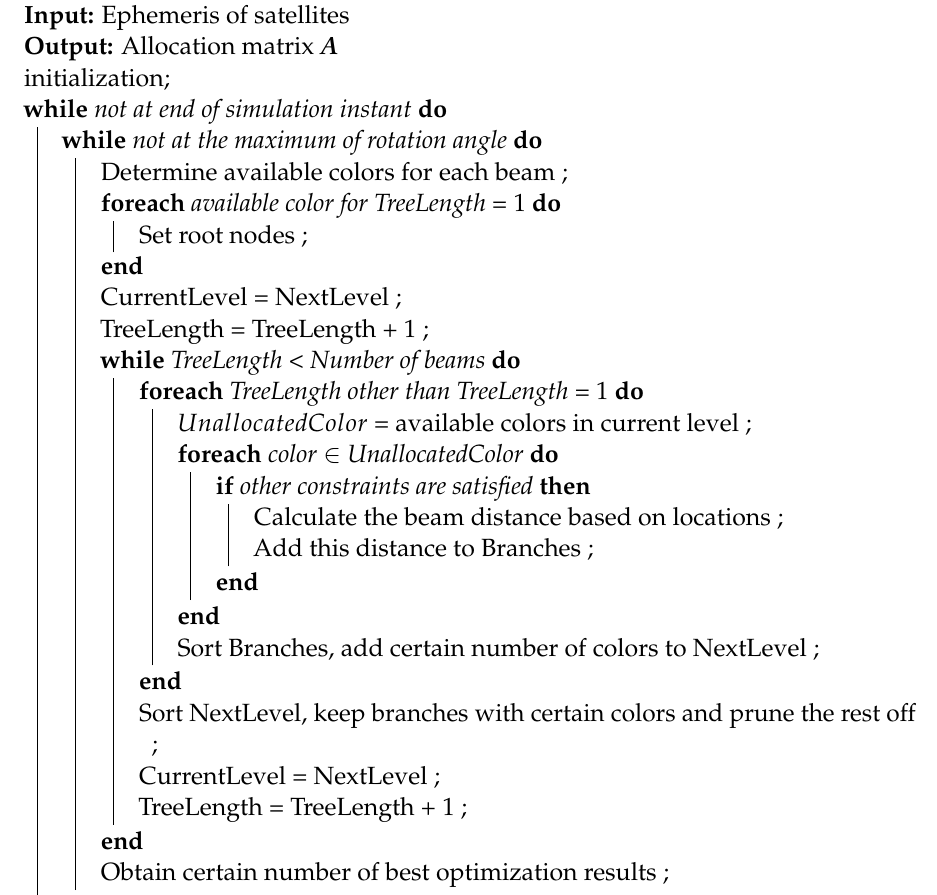
Algorithm 1: Beam search-based channel allocation